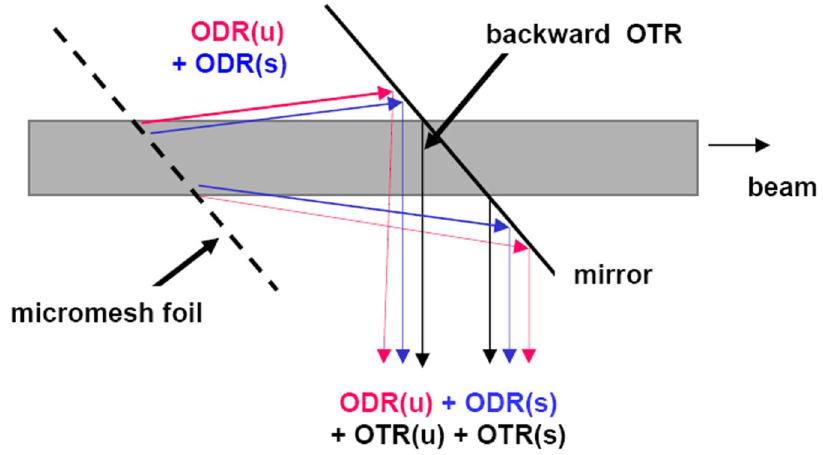
FIG. 1. (Color) Schematic of the ODTR Interferometer showing various radiation